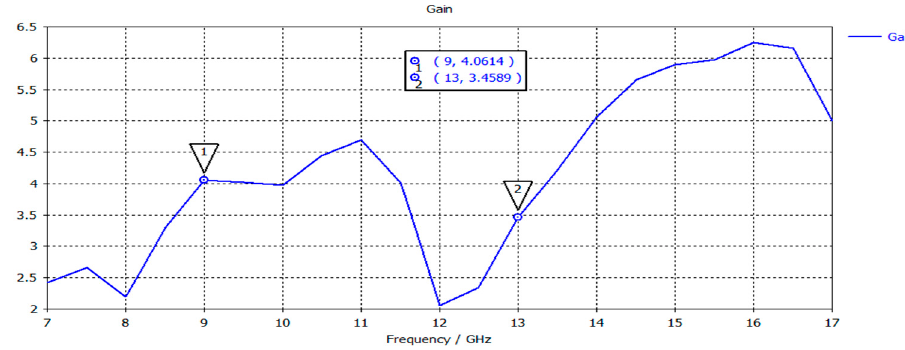
Figure 6. Radiation pattern of the proposed MPA.